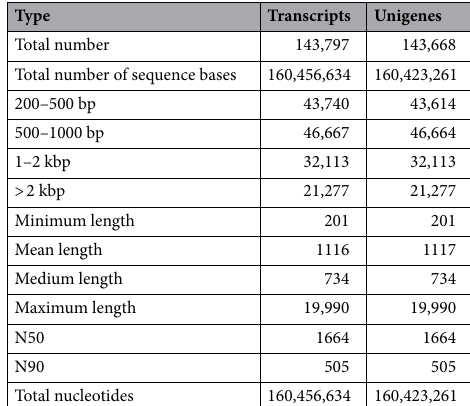
Table 1. Statistics of the assembly quality.